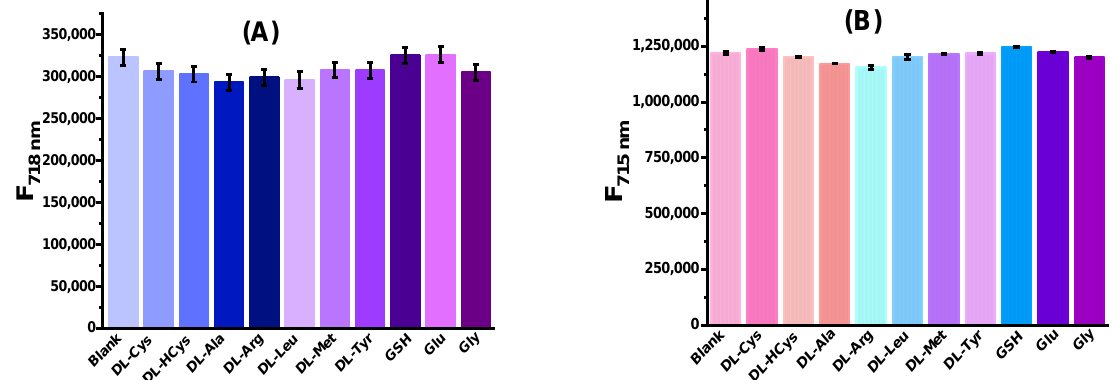
Figure 9. Fluorescence intensities of 10 μM probes AH + ( A ) and probe BH + ( B ) in the absence and presence of different anions (200 μM) in pH 7.4 buffers under excitation at 635 nm, respectively.